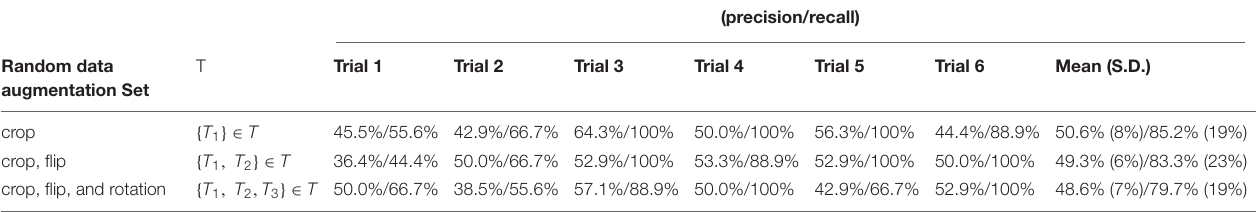
TABLE 2B | Classification precision and recall for the test sets per trial, for all three data augmentation strategies.